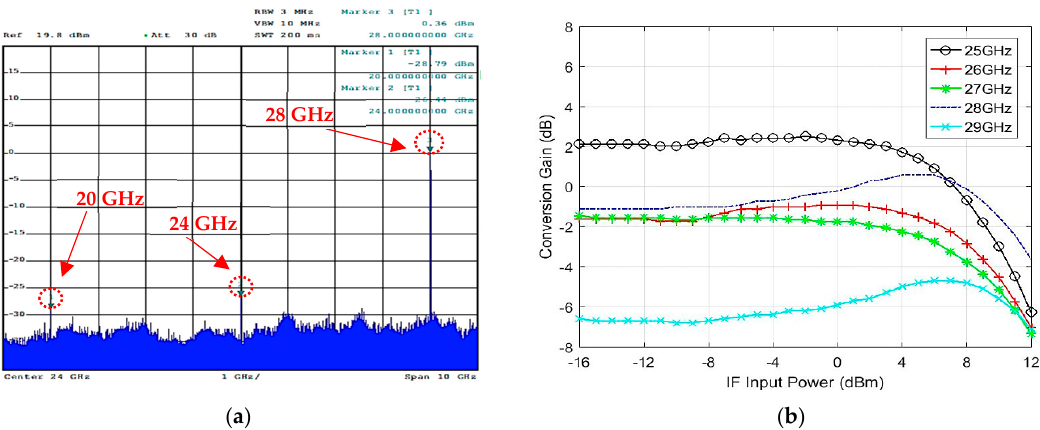
Figure 6. Measurements of upconverter module: ( a ) RF output spectrum (M1@20 GHz, M2@24 GHz, M3@28 GHz; ( b ) upconverter conversion gain at different RF frequencies.